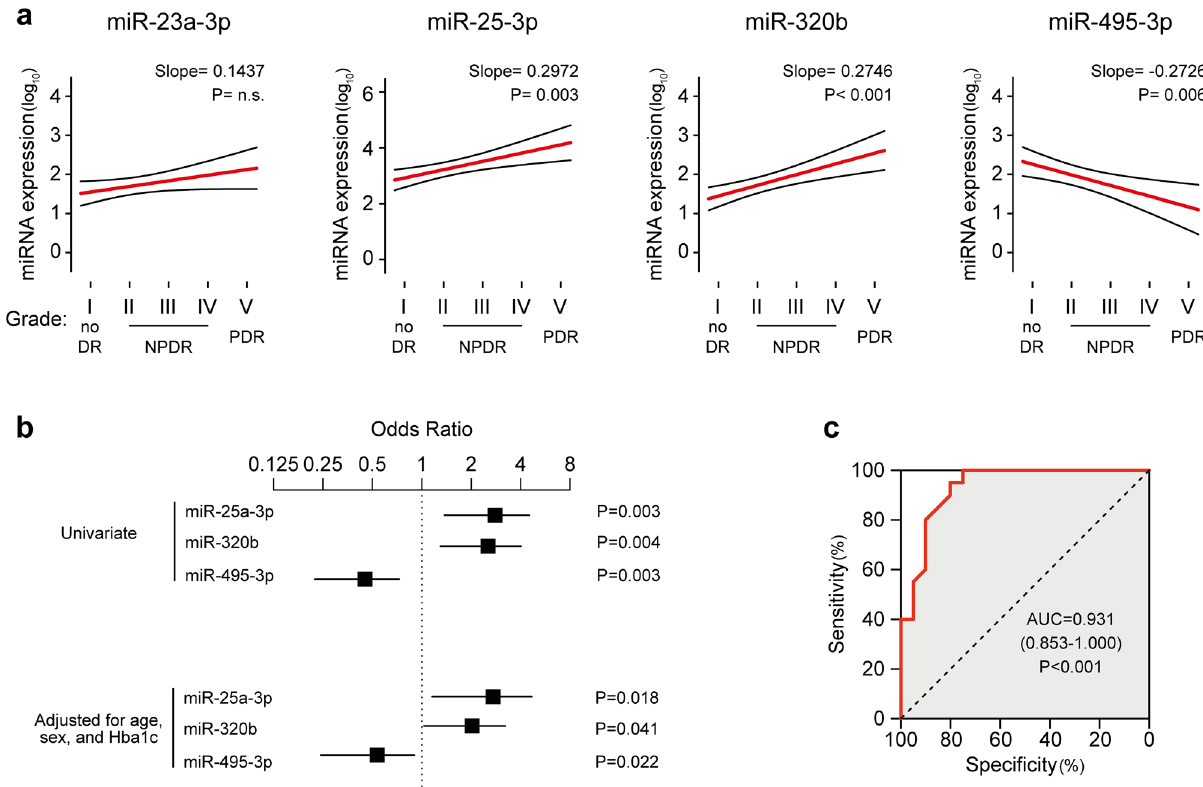
retinopathy (n = 10); Grade II, mild no-proliferative DR (NPDR, n = 5); Grade III, moderate NPDR (n = 5); Grade IV, severe NPDR (n = 7); Grade V, proliferative DR (n = 3). ( b ) Forest plot showing odds ratios and